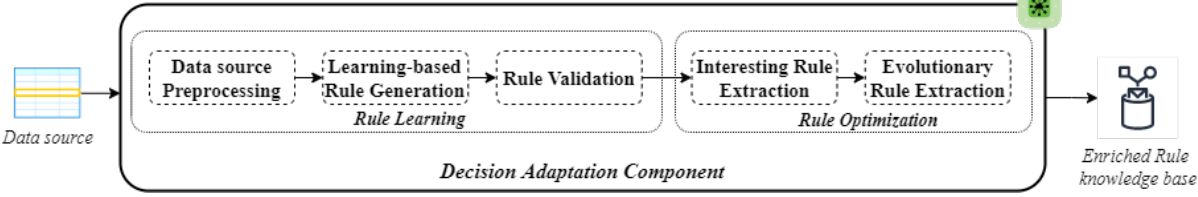
Figure 2. Architecture overview of the decision adaptation